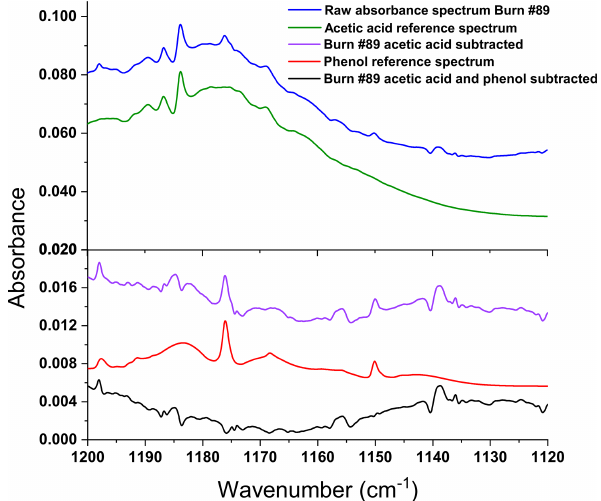
Figure 5. Static spectrum obtained from Burn 89 (1kg of longleaf pine needles with inkberry). The blue trace is the FTIR experimental spectrum, the green trace the reference spectrum of acetic acid, the purple trace the residual after acetic acid subtraction, the red trace the reference spectrum of phenol, and the black trace the residual after both acetic acid and phenol